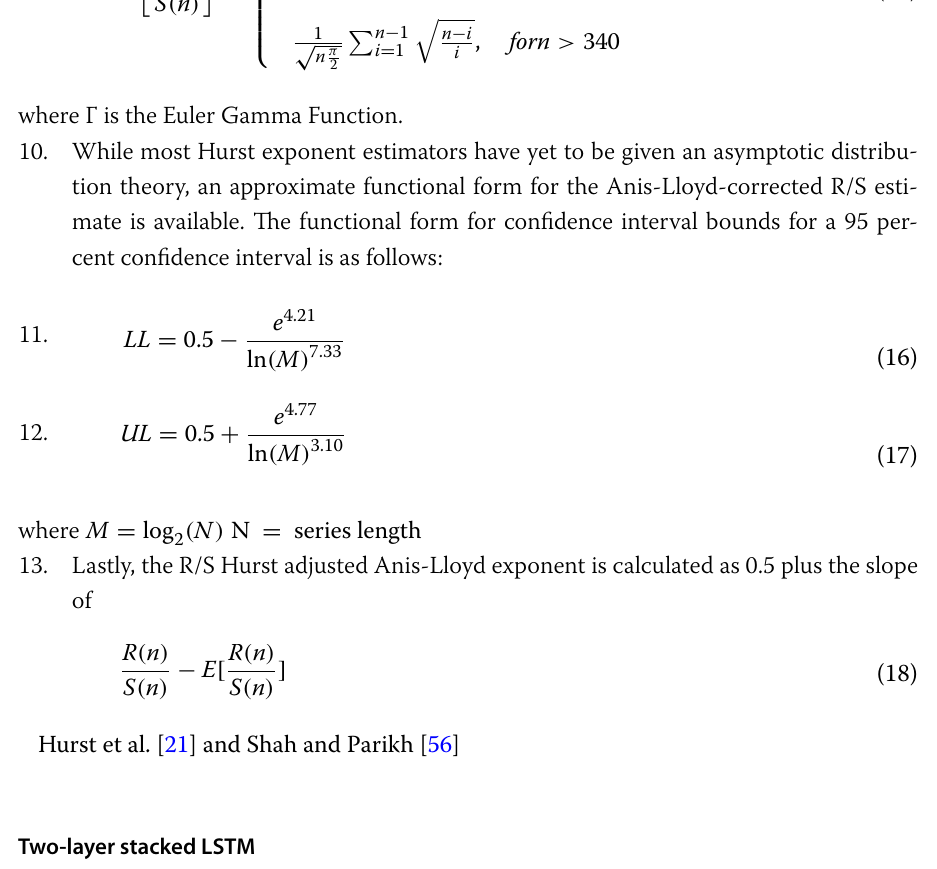
From Fig. 4, the LSTM network architecture [24] for numerical research consists of one input layer, two LSTM layers, and one output layer. One neuron is present in the output layer, whereas 128 LSTM cells are present in each of the first and second layers. The anticipated exchange rate x k is determined by h k − 1